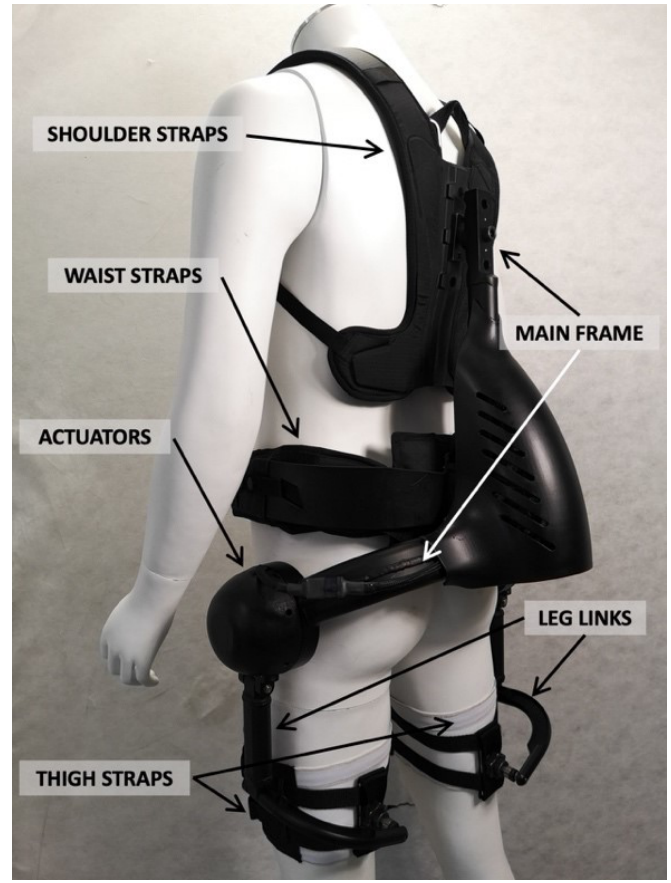
Figure 1. XoTrunk